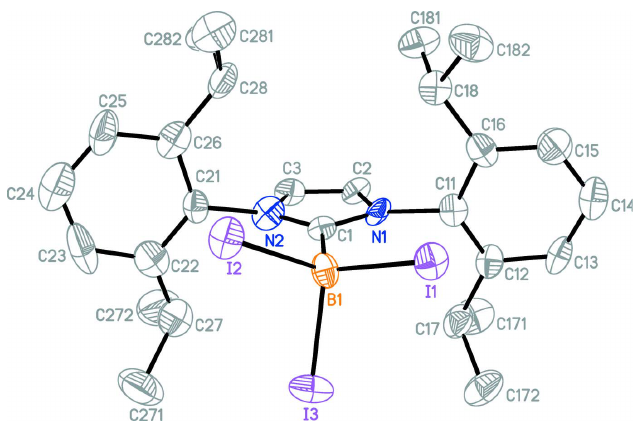
Figure 2 A perspective view of the NHC-molecule in the title compound; H atoms and the solvent benzene molecule have been omitted for clarity. Displacement ellipsoids are drawn at the 50% probability level.